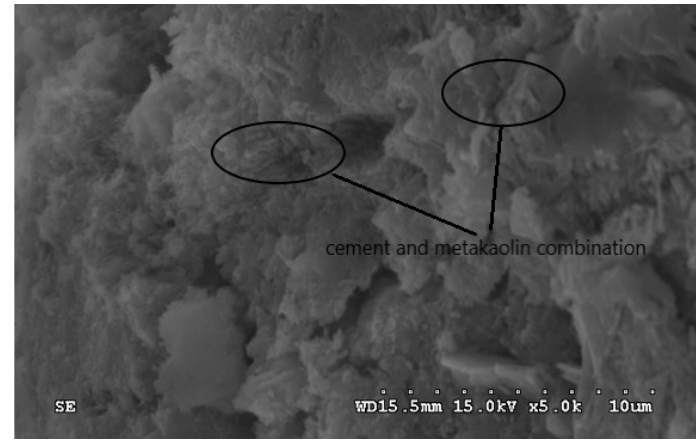
Figure 20. GS7 paste SEM in 5000 k image.